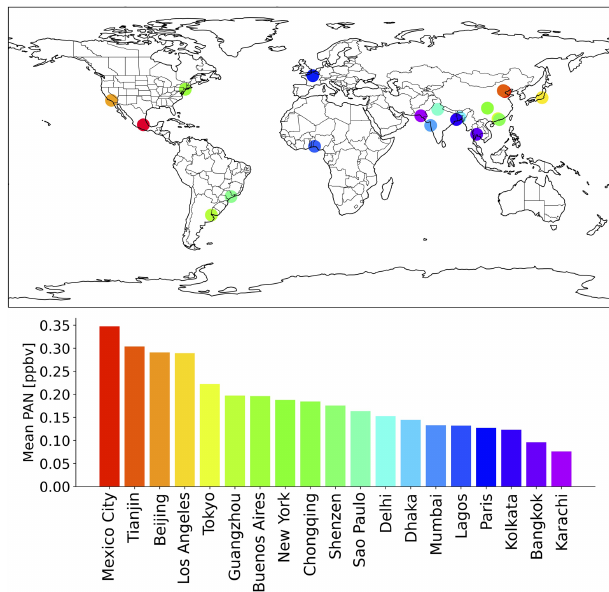
Figure 2. Ranked mean PAN in TES megacity transects collected between 2013 and